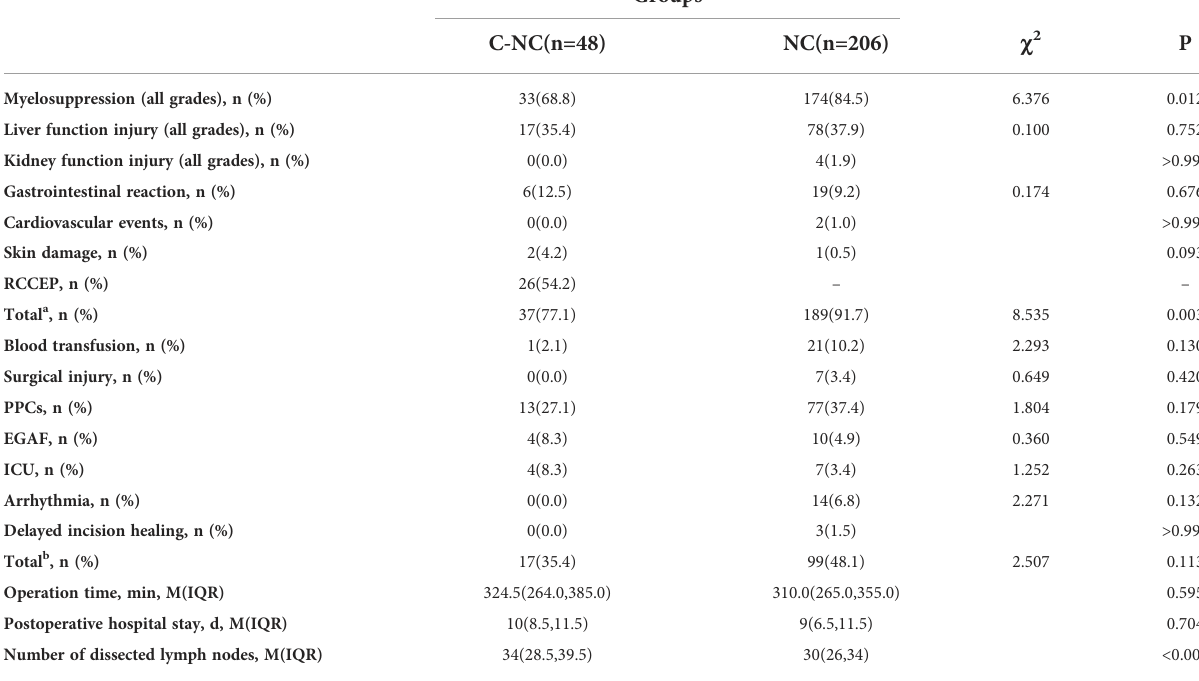
TABLE 4 Adverse events during neoadjuvant therapy and the perioperative period and perioperative data.